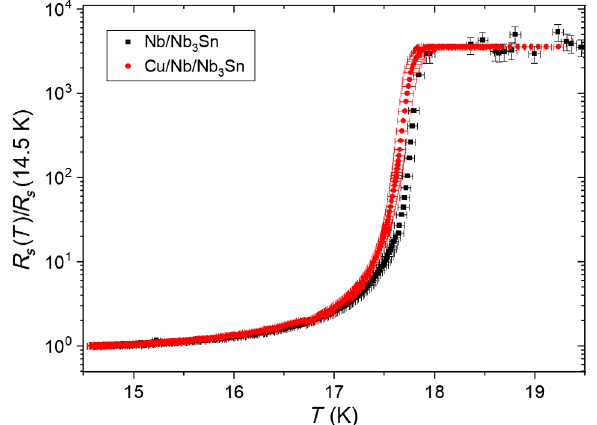
ð T Þ =R ð 15 K Þ between 14.5 – 19.5 K measured FIG. 14. R s s before and after growing the Cu structure on the cavity outer surface.